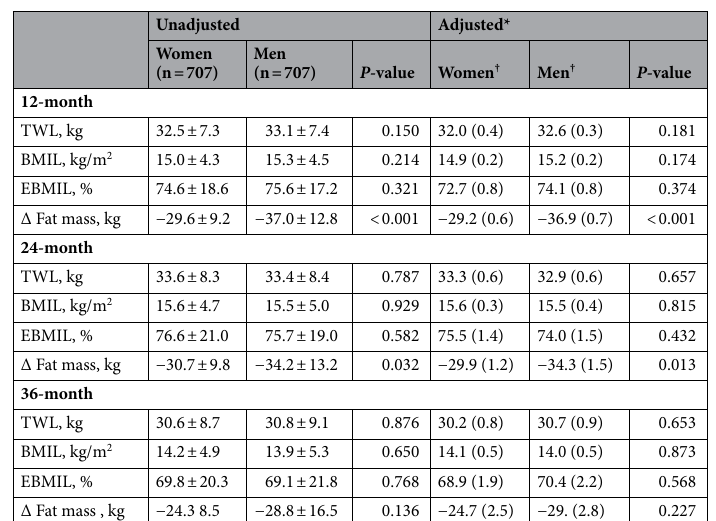
Table 3. Matched comparison of anthropometric parameters between men and women after 12, 24 and 36 months postoperatively. TWL, total weight loss; BMIL, body mass index loss; EBMIL, excess body mass index loss. *Model adjusted for preoperative diabetes mellitus, hypertension and dyslipidemia. † Data are presented as mean (Standard